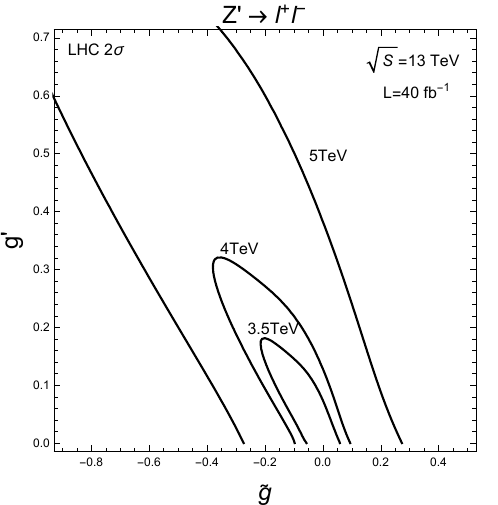
Figure 2 . Significance analysis for the di-lepton ( l = e, µ ) channel at the LHC for different Z ′ masses and = 40 fb − 1 L